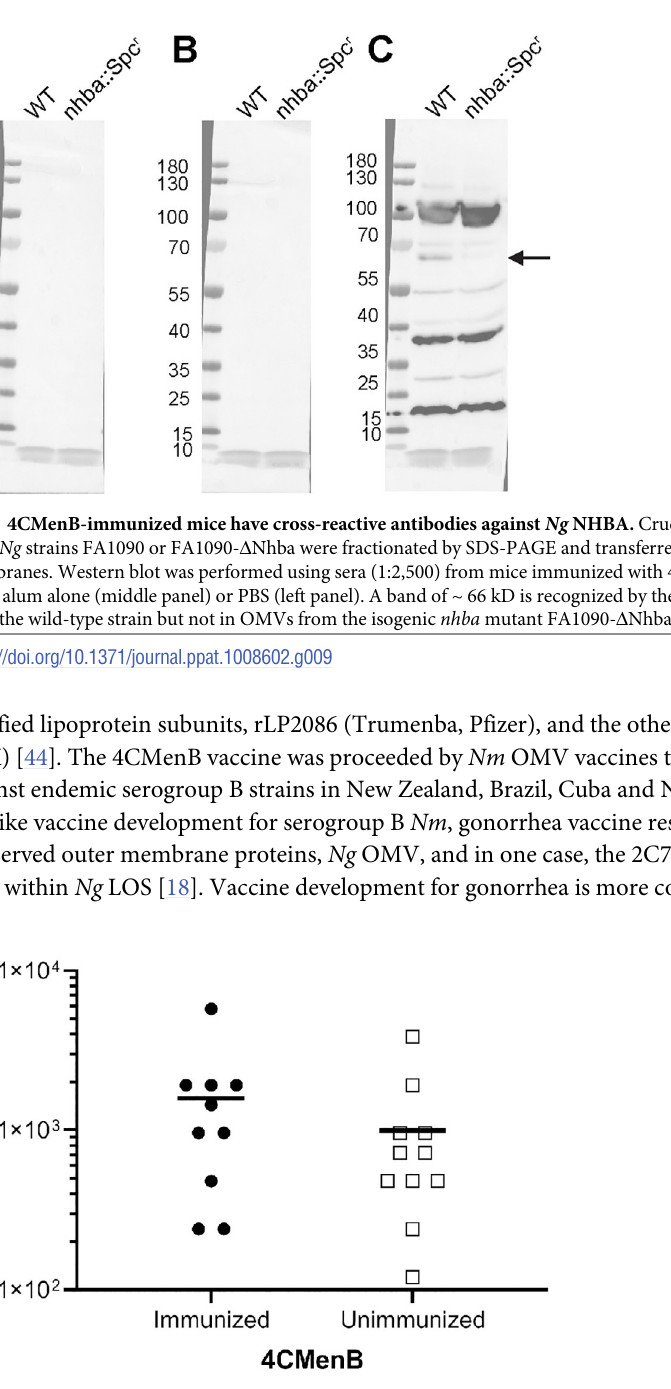
Fig 10. Serum from 4CMenB-immunized and unimmunized individuals showed no significant difference in bactericidal activity against the challenge strain. Human serum from ten 4CMenB-immunized and eleven unimmunized individuals was tested for bactericidal activity against Ng strain F62. The bactericidal 50 titer is shown for each individual (immunized: mean 1,584, median 1,200; unimmunized: mean 993, median 720). The difference in the two groups was not significant (unpaired t-test, p = 0.3). The interval between the second dose of 4CMenB and the date of serum collection ranged from 2 months (2 individuals), 4 months (6 individuals) and 15–16 months (2 individuals), with no potential correlation observed between number of months post-vaccination and bactericidal 50